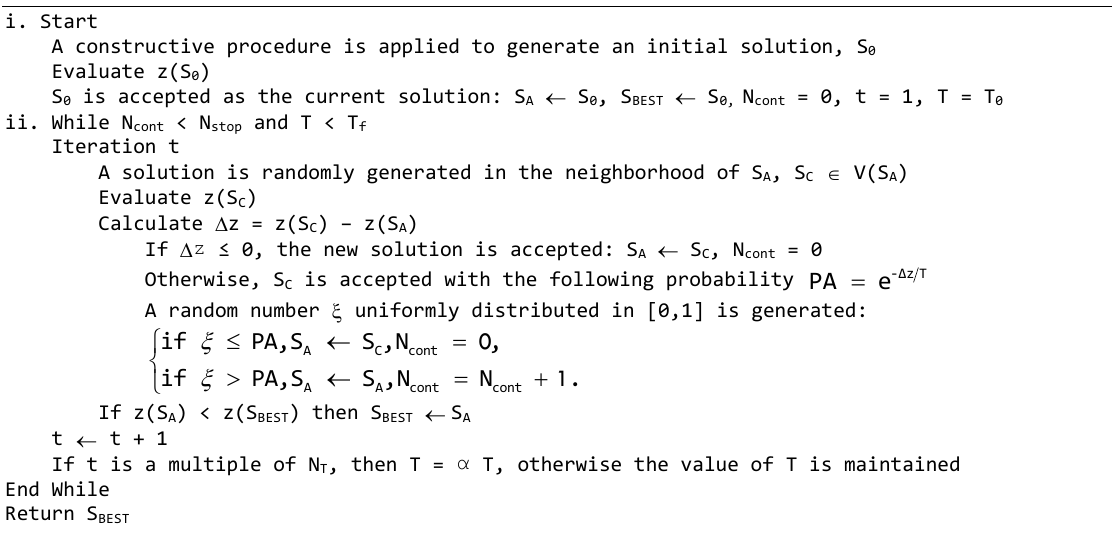
Algorithm 1: Pseudo-code of the proposed SA algorithm for